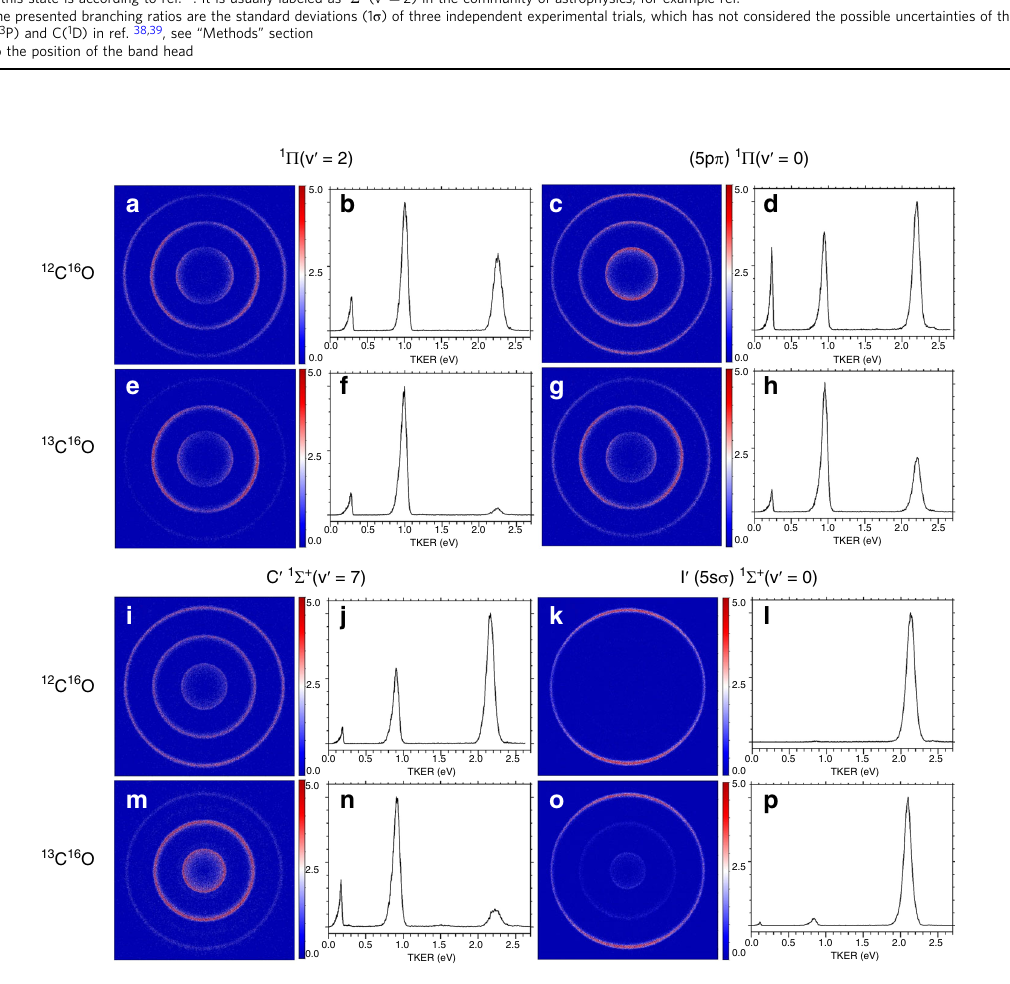
Fig. 2 State dependent isotope effect of the photodissociation branching ratios. The comparisons of the raw time-slice velocity map imaging (TSVMI) images and the corresponding total kinetic energy release (TKER) spectra between the photodissociations of 12 C 16 O and 13 C 16 O for the absorption bands with upper states of 1 Π (v ′ = 2) ( a , b , e , f ), (5p π ) 1 Π (v ′ = 0) ( c , d , g , h ), C ′ 1 Σ + (v ′ = 7) ( i , j , m , n ) and I ′ (5s σ ) 1 Σ + (v ′ = 0) ( k , l , o , p ). The outermost, middle and innermost rings in the TSVMI images are corresponding to the peaks with largest (2.0 – 2.3 eV), medium (0.8 – 1.0 eV) and smallest (0.1 – 0.3 eV) kinetic energies in the TKER spectra, respectively. The heights of the three peaks are rescaled by setting the highest peak in each spectra to 1. The underneath areas of the peaks represent the relative intensities (or branching ratios) of the three photodissociation channels C( 3 P) + O( 3 P), C( 1 D) + O( 3 P) and C( 3 P) + O( 1 D) respectively after normalization by using the photoionization cross sections of C( 3 P) and C( 1 D) (see directly revealed in Fig. 2a, b, e, f, i, j, m, n, respectively. Relatively predissociation process with percentages of ~79% and ~62%, and large variation of the branching ratio has also been observed for the corresponding percentages of the lowest dissociation channel the absorption band of (5p π ) 1 Π (v ′ = 0), in which case the decrease to ~9% and ~22%, respectively for the two absorption bands. These huge branching ratio variations (up to 50%) between substitution of 12 C by 13 C decreases the relative percentage 12 C 16 O and 13 C 16 O in the above two absorption bands have been of C( 3 P) + O( 3 P) from ~62% to ~45%, and increases that of